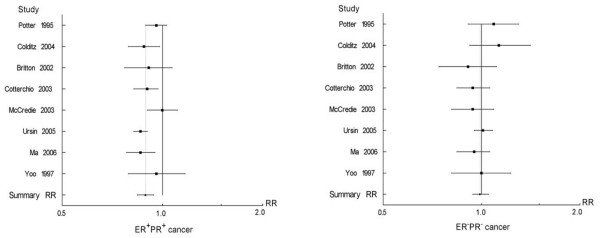
Parity and breast cancer risk by estrogen receptor/progesterone receptor (ER/PR) status: relative risk (RR) with corresponding 95% confidence interval per birth.